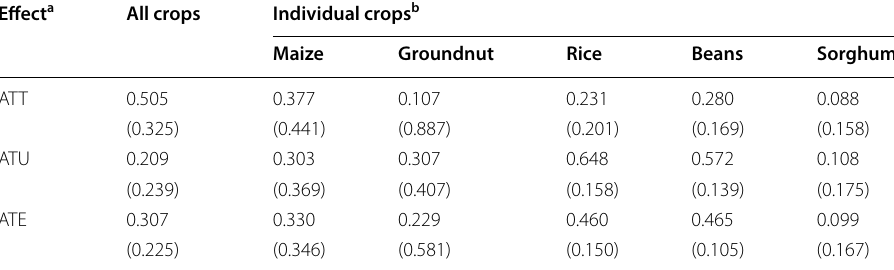
Figures in parentheses are standard deviations